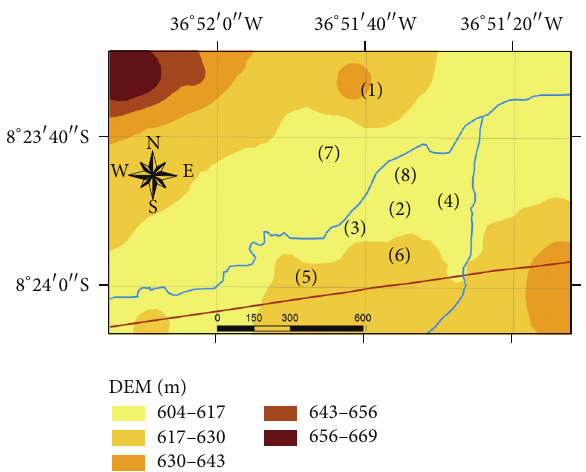
Figure 1: Localization of the studied stands (scale =